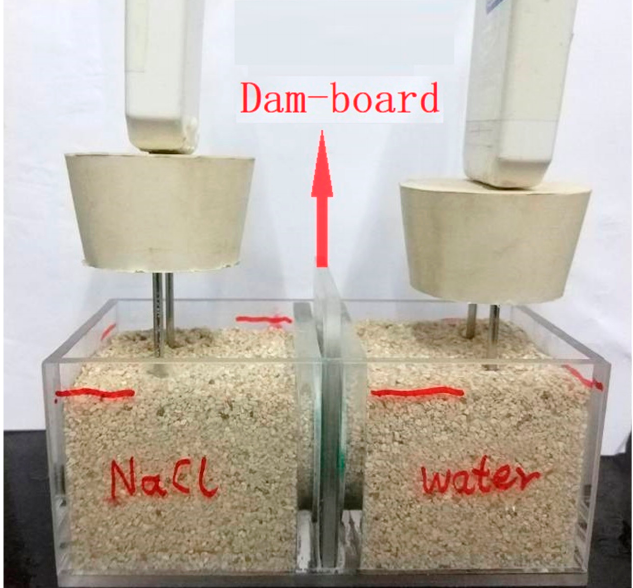
Figure 5. Molecular diffusion and pore tortuosity test device .